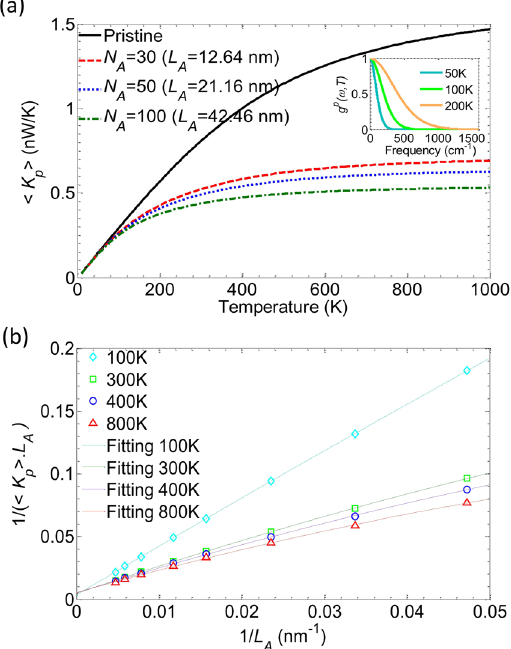
Figure 4. ( a ) Average phonon conductance as a function of temperature for different device lengths with 70% isotope doping. The solid black corresponds to the pristine structure. The inset reports the distribution function g p ( ω , T ) at different temperatures. ( b ) The inverse of the phonon thermal conductivity as a function of 1/ L A . Symbols are numerical results and the solid lines are the fitting curves. Data provided for M = 5